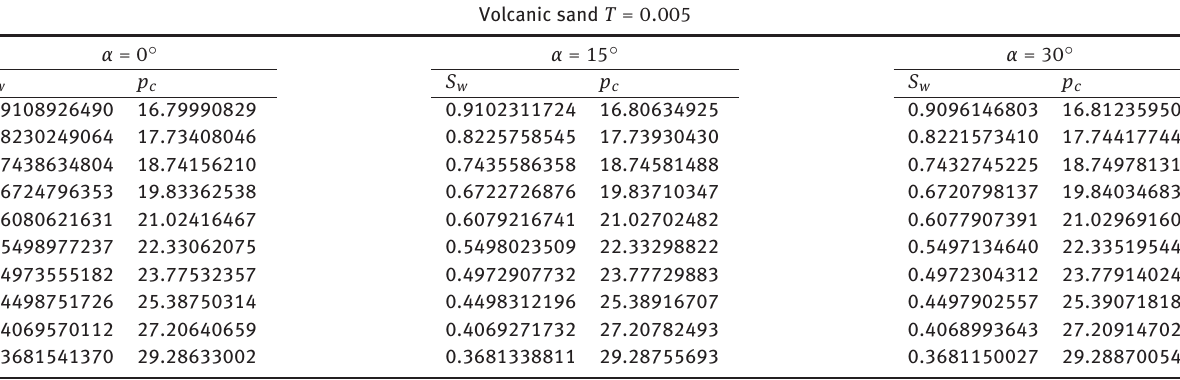
Table 5: Comparison of the numerical values for saturation vs. capillary pressure in heterogeneous porous media for volcanic sand at differ- ent inclined plane α = 0 ◦ , 15 ◦ , 30